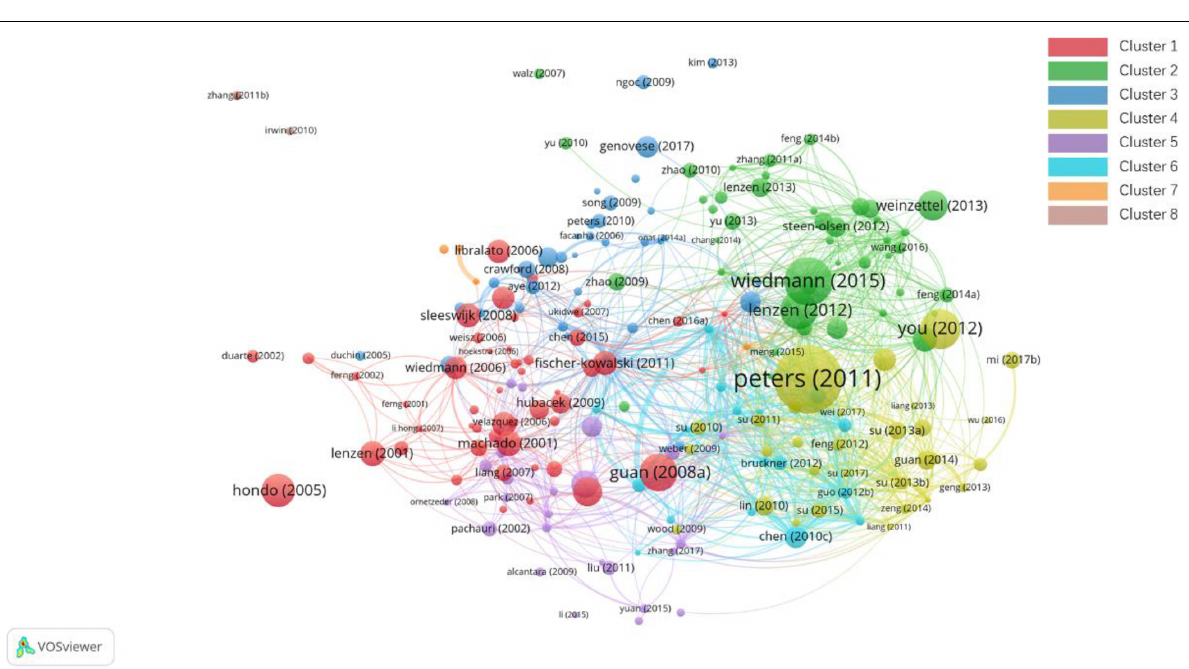
FIGURE 3 | Bibliographic coupling of highly cited